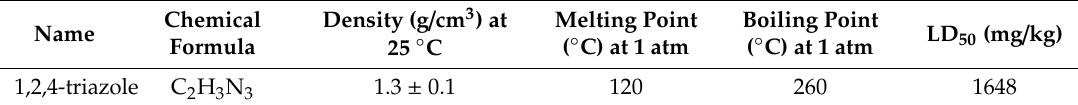
Table 2. Physical properties of